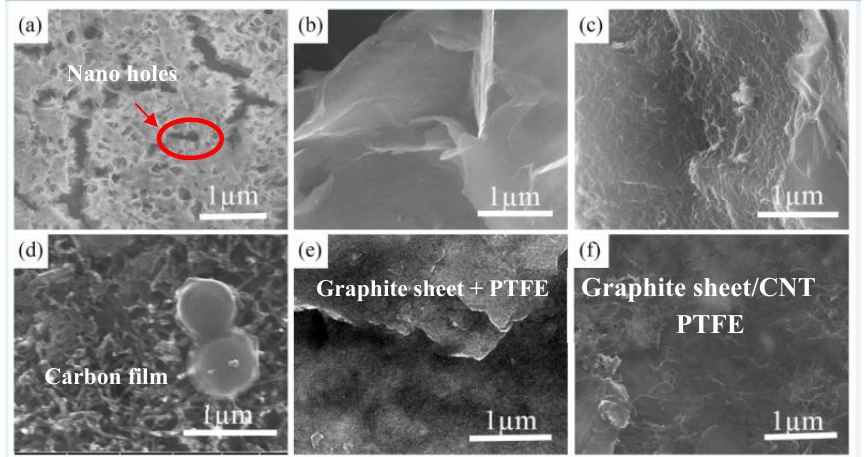
Figure 3. SEM images of the surface morphology ( a ) Ti upon immersing in 8 mol/L NaOH solution ( b ) Graphite sheets prepared by mechanical stripping; ( c ) Graphite sheets mixed with carbon nano- tubes; ( d ) carbon coating prepared in 0.1 mol/L glucose solution; ( e ) composite coating of carbon, graphite and PTFE; ( f ) composite coating of carbon and graphite sheet mixed with carbon nanotubes and PTFE.